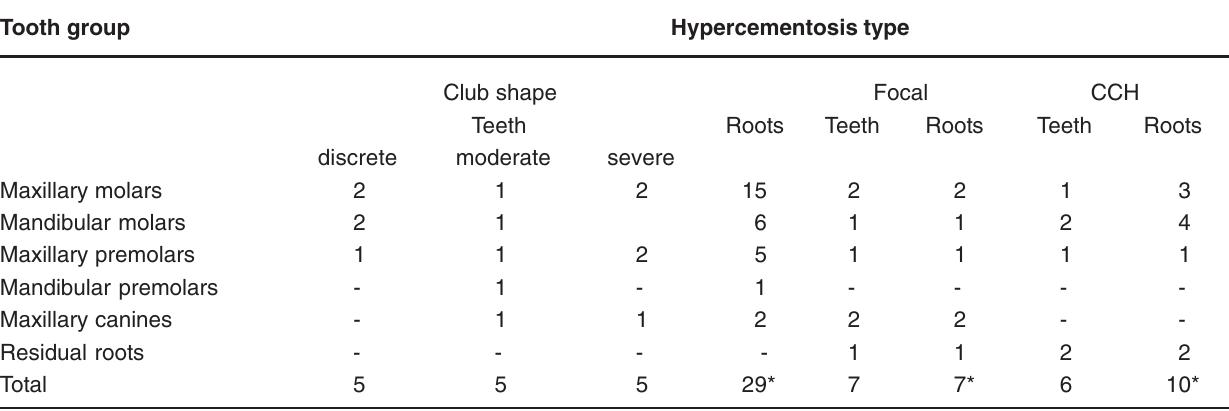
* A total of 41 specimens were obtained from a total of 46 roots.